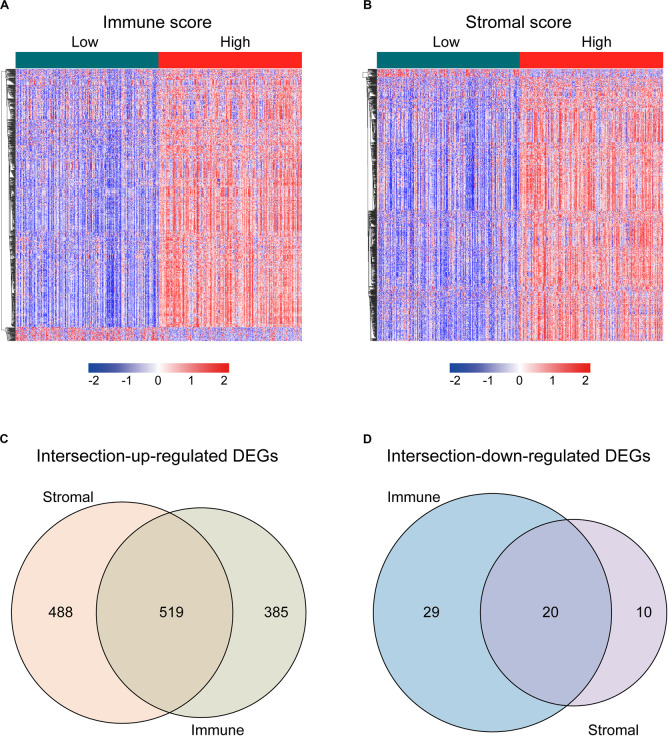
Identification of the intersection DEGs among immune and stromal scores in LUAD. (A) Heatmap of the DEGs of immune scores of top half (high score) vs. bottom half (low score). Cutoff: | log2(fold-change)| > 1, FDR < 0.05. (B) Heatmap of the DEGs of stromal scores of top half (high score) vs. bottom half (low score). Cutoff: | log2(fold-change)| > 1, FDR < 0.05. (C,D) Venn diagrams showing the number of intersection-upregulated DEGs (C) or intersection-downregulated DEGs (D) in stromal and immune score groups. Heatmaps were drawn based on the average method and correlation distance measurement method. Genes with higher expression are shown in red, lower expression are shown in blue, genes with the same expression level are in white. DEGs, differentially expressed genes; LUAD, lung adenocarcinoma; FDR, false discovery rate.